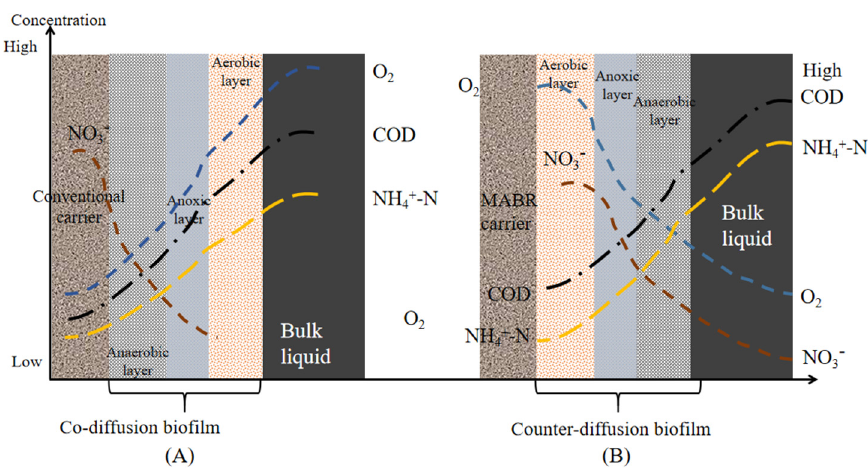
Figure 4. Mass transfer process of different carrier biofilm materials, ( A ) conventional carrier biofilm, ( B ) MABR carrier biofilm.